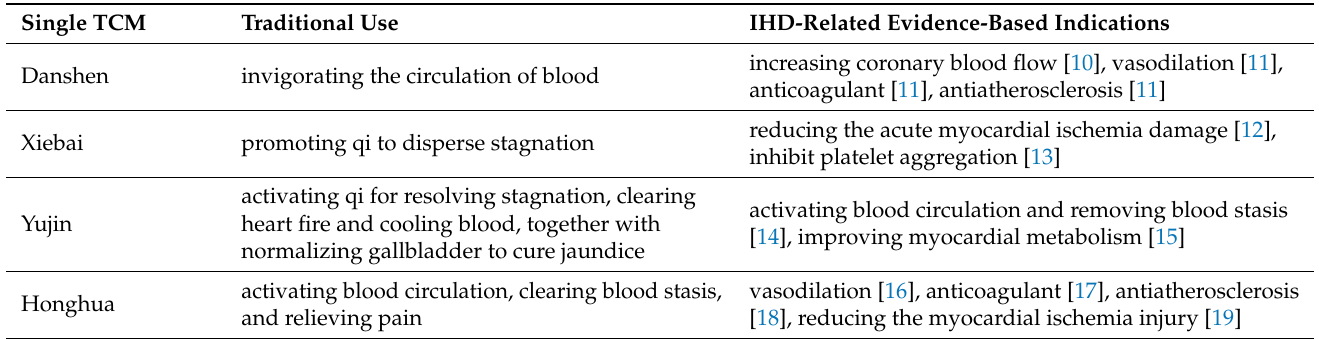
Table 3. The traditional use and evidence-based indications for each single TCM related to